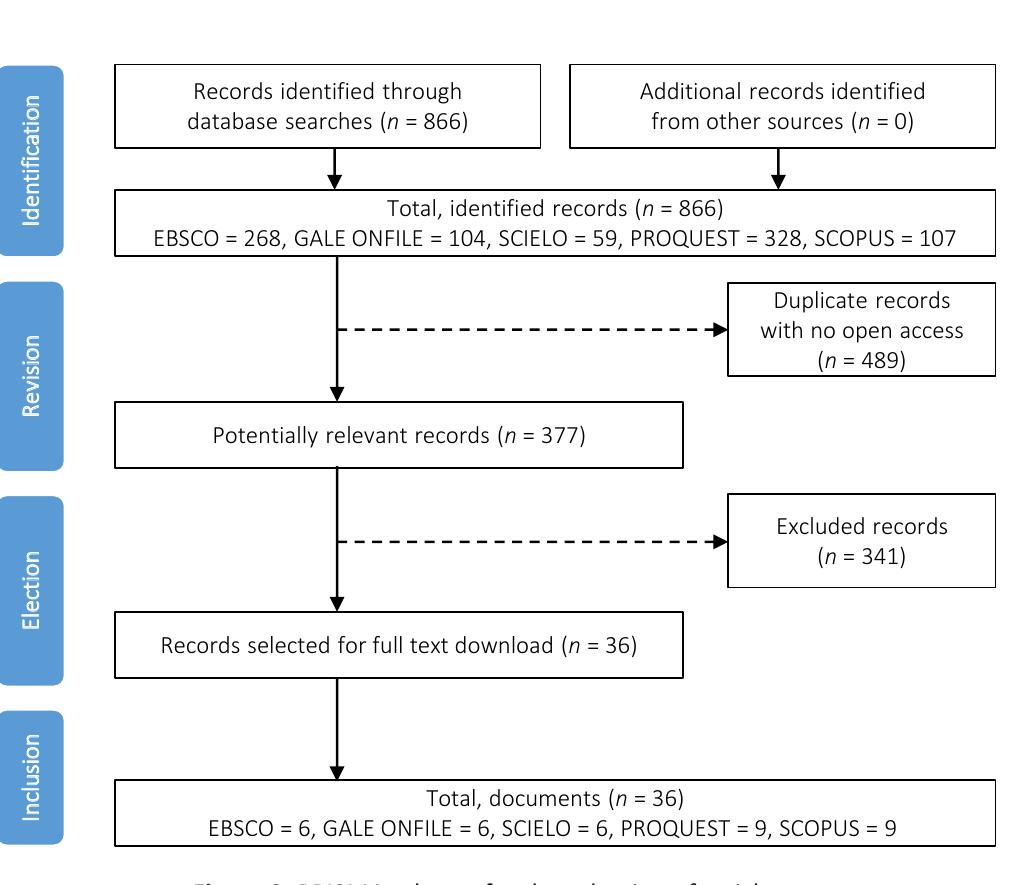
Figure 2. PRISMA scheme for the selection of articles